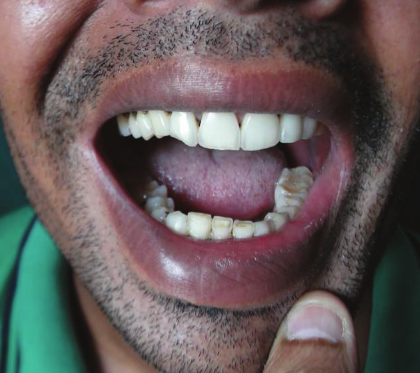
Figure 12: Photograph of the teeth of the patient six weeks after the